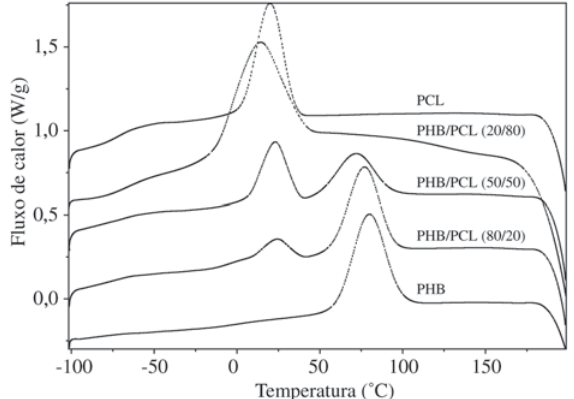
Figura 4. Curvas de fluxo de calor total, obtidas por MDSC para as blendas P(3-HB)/PCL no resfriamento.